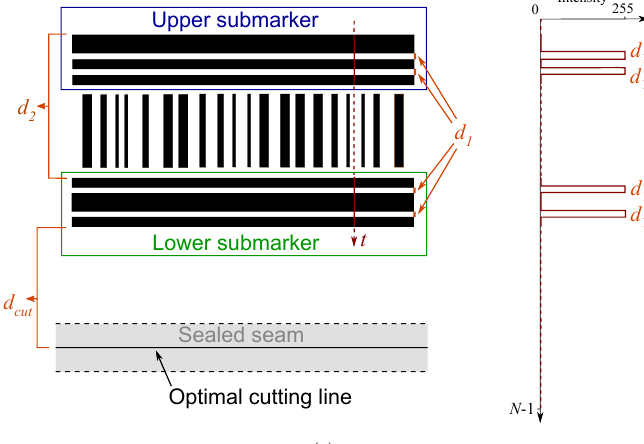
on intensity values ( cf. scheme on the right). Dashed line parts are ignored. The distance d cut from the lower submarker to the optimal cutting line is assumed to be